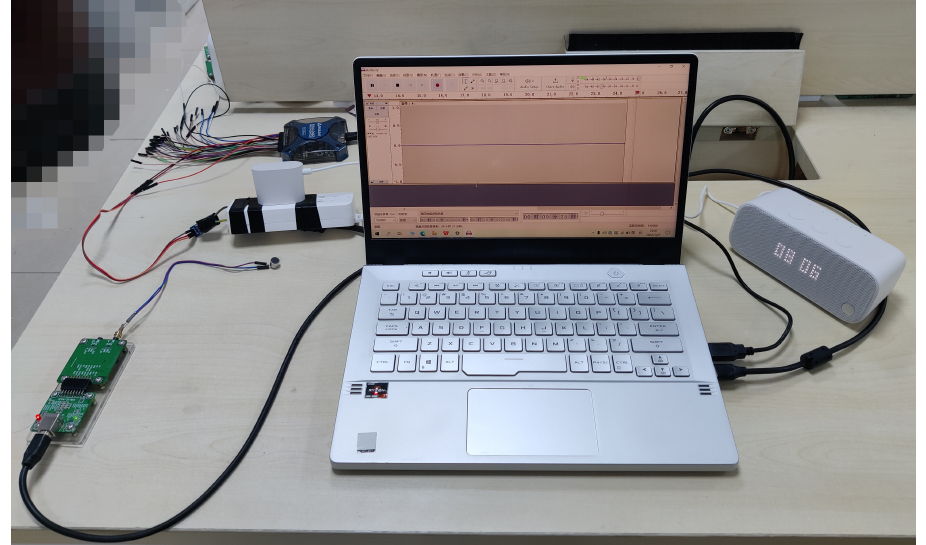
Figure 8. Illustration of data collection